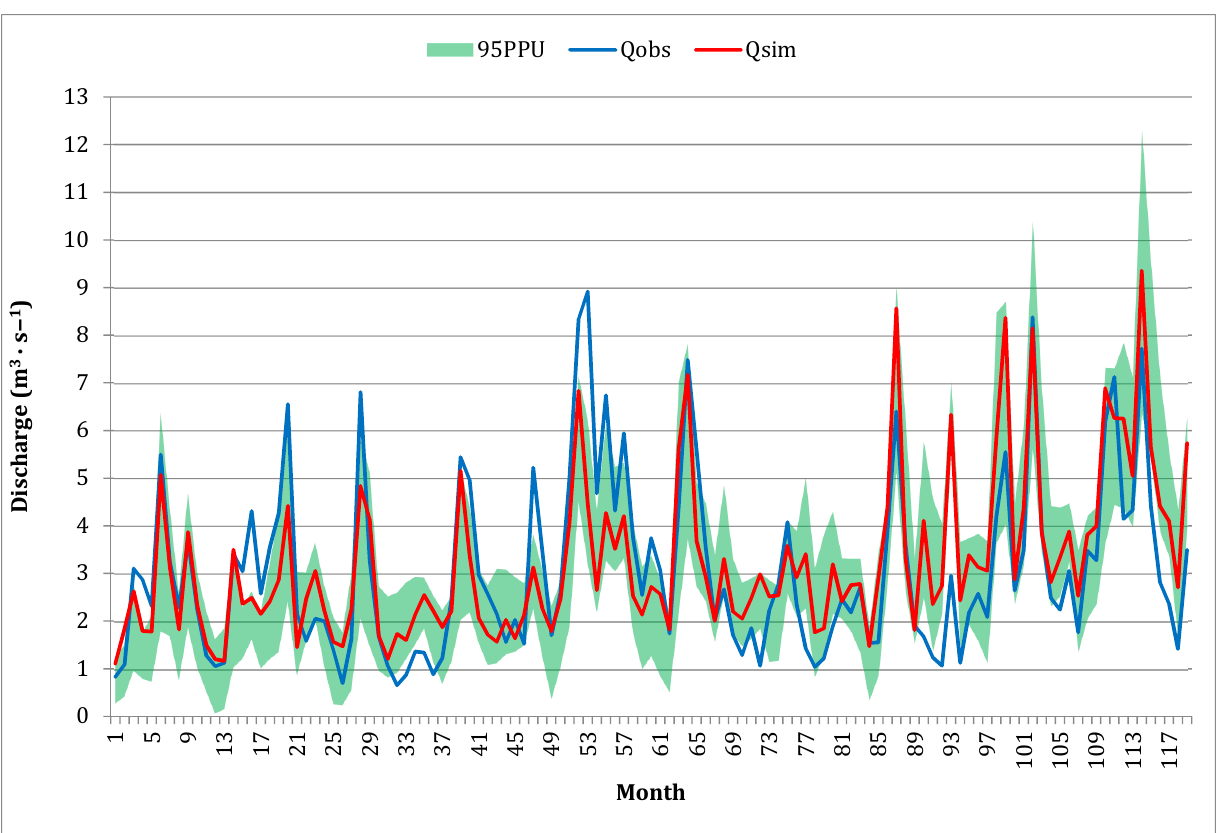
Figure 5. Simulated river discharge (Qs), measured river discharge (Qm) and precipitations (PP) for the Tărlung watershed for the 2001‒2010 period.